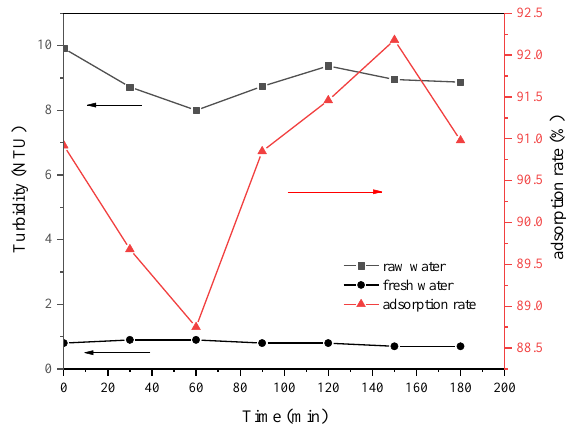
Figure 6. Effect of operating pressure on the membrane flux.